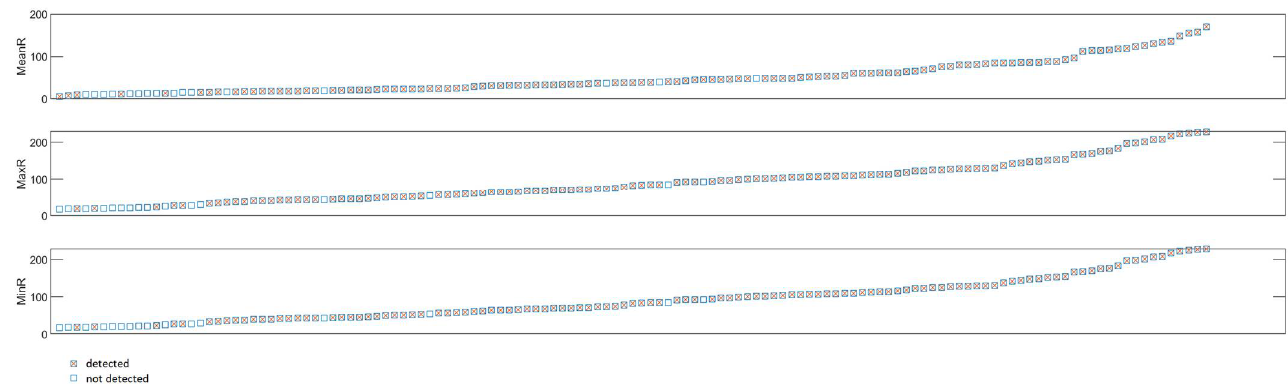
Figure 10. Analysis of the F-points’ detection ability, depending on the luminosity.